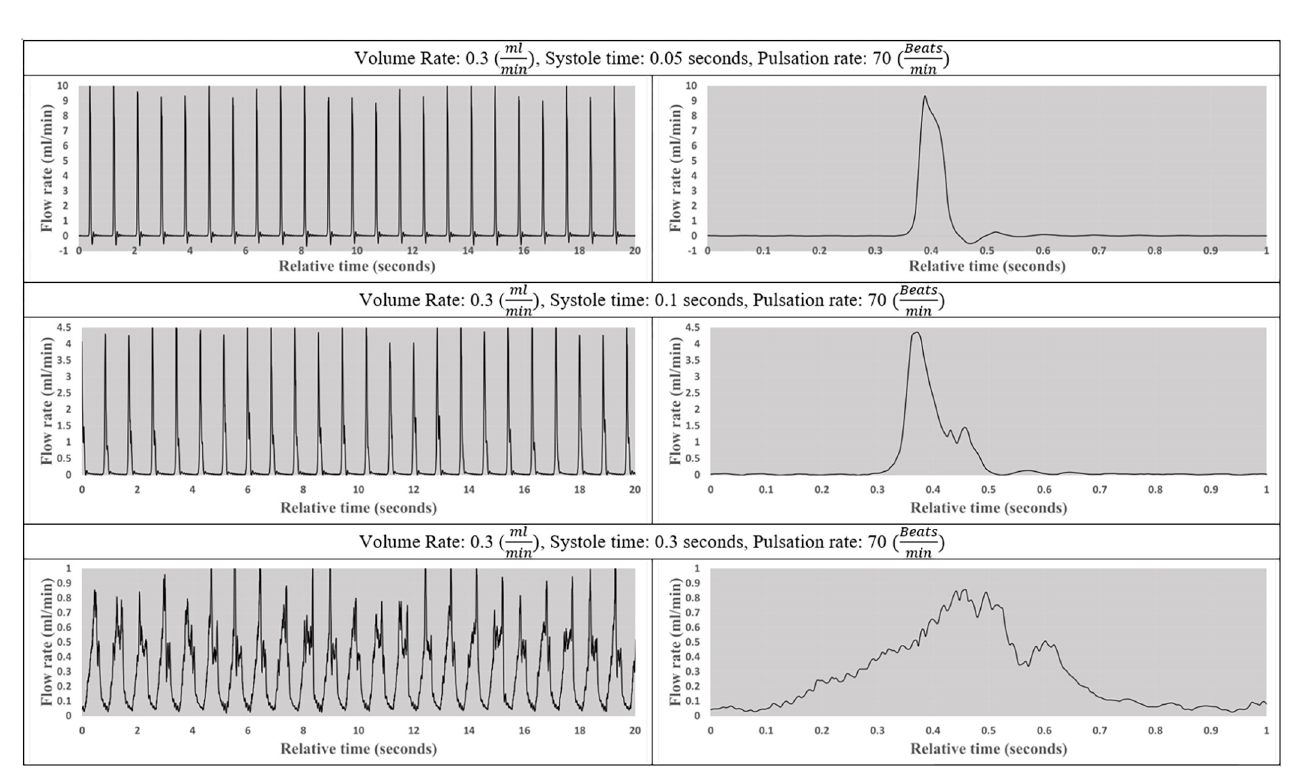
Fig 6. The impact of varying systole time on flow pattern. Visual representation of flow pattern at various systole times while heart rate and volume rate remained constant at 70 beats and 0.3 ml , respectively. min min